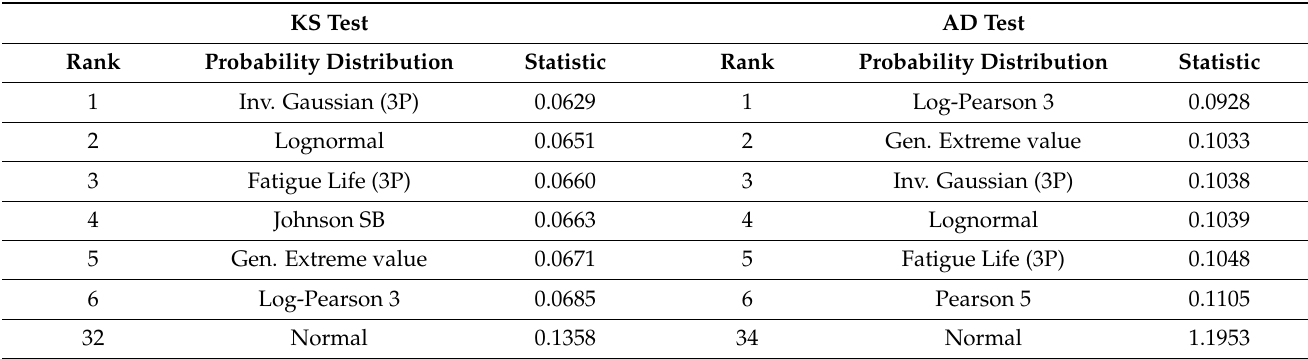
Table 4. Result of goodness-of-fit test under unloading condition.